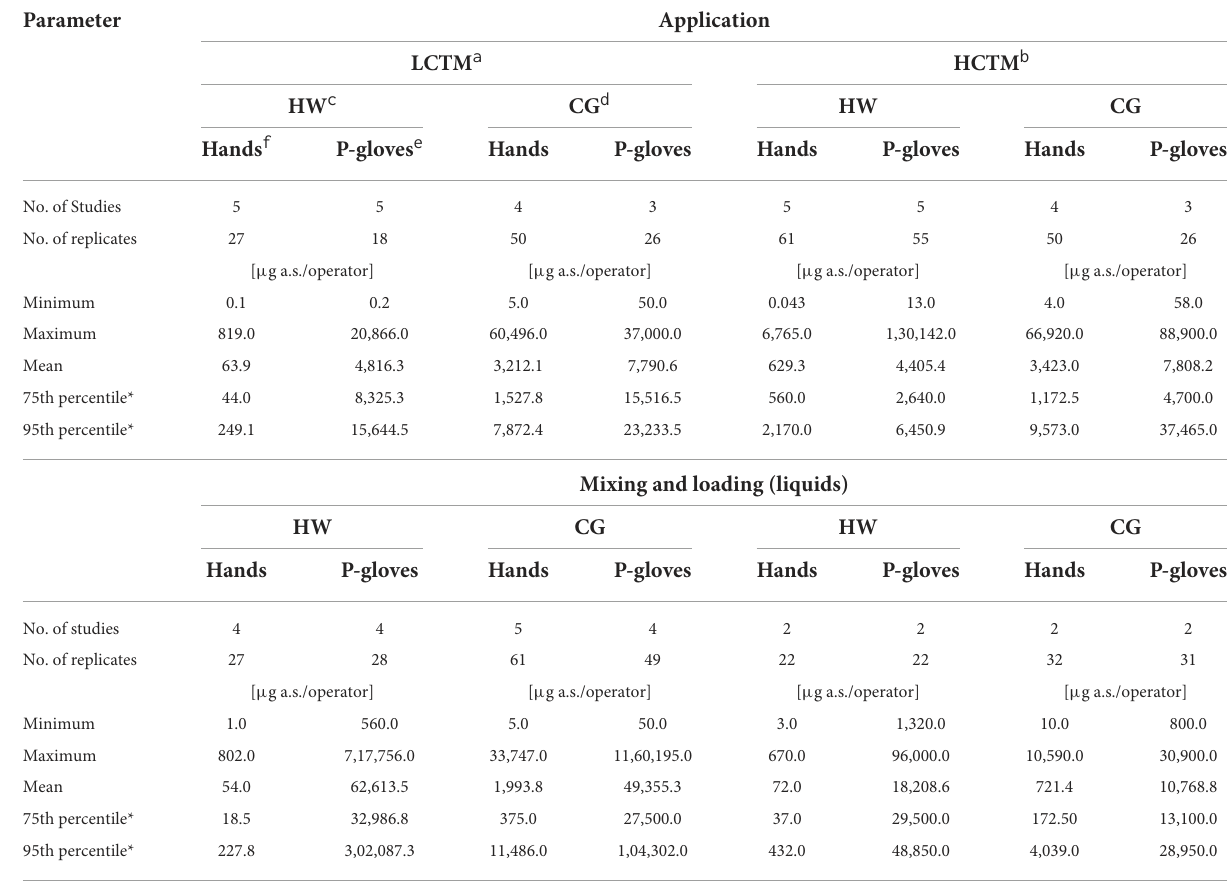
TABLE 2 An overview of results expressed as µ g